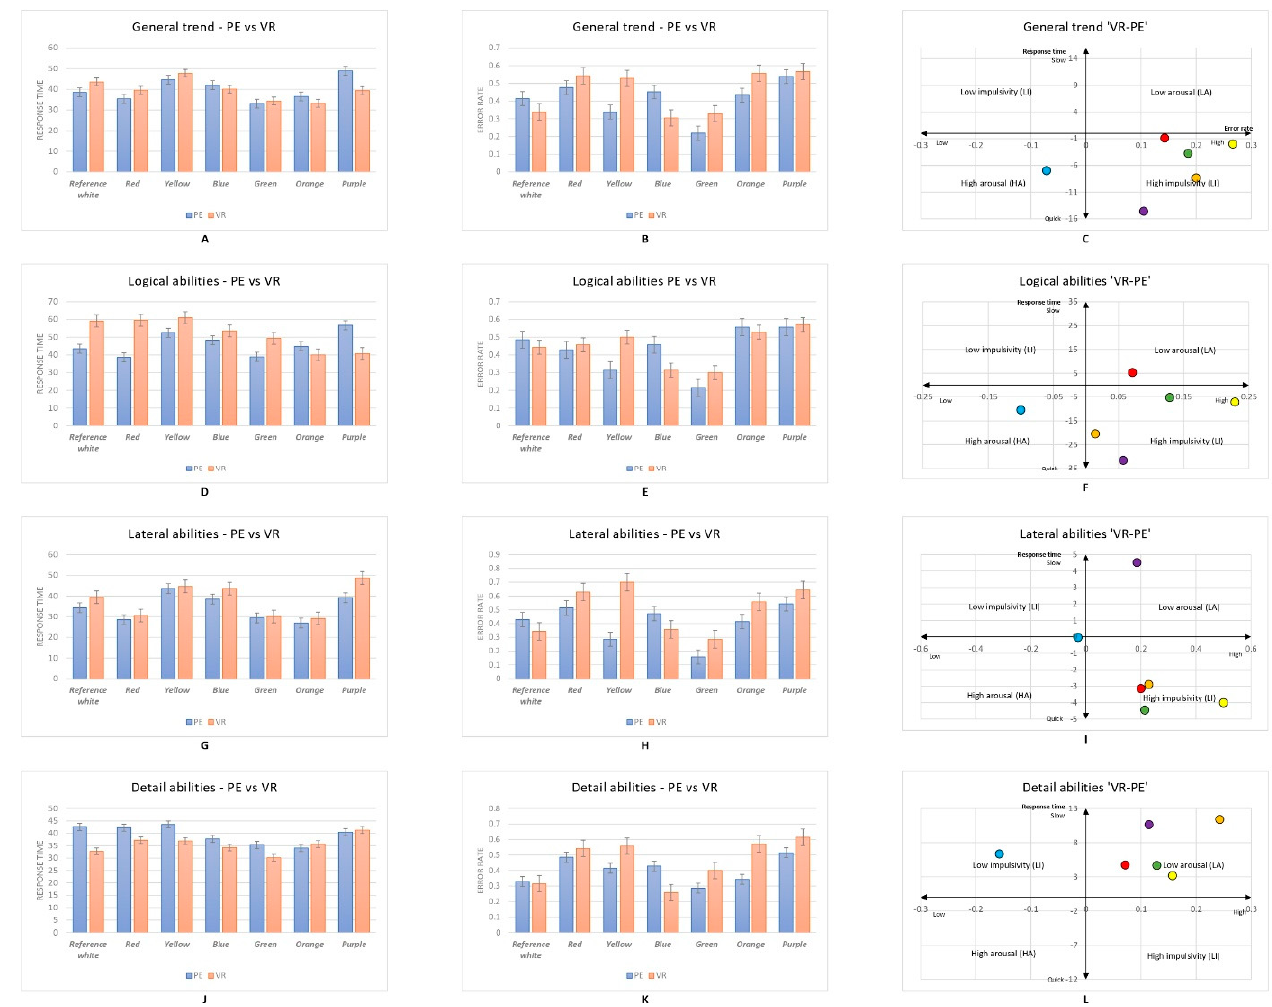
Figure 4. ( A ) General trend of response time by background colour in PE and VR; ( B ) general trend of error rate by background colour in PE and VR; ( C ) colour impacts (in VR compared with PE) on general performance visualised in the Error–Speed space; ( D ) response time of participants’ performance in logical abilities by background colour in PE and VR; ( E ) error rate of participants’ performance in logical abilities by background colour in PE and VR; ( F ) colour impacts (in VR compared with PE) on logical abilities in VR visualised in the Error–Speed space; ( G ) response time of participants’ performance in lateral thinking abilities by background colour in PE and VR; ( H ) error rate of participants’ performance in lateral thinking abilities by background colour in PE and VR; ( I ) colour impacts (in VR compared with PE) on lateral thinking abilities in VR visualised in the Error–Speed space; ( J ) response time of participants’ performance in detail abilities by background colour in PE and VR; ( K ) error rate of participants’ performance in detail abilities by background colour in PE and VR; ( L ) colour impacts (in VR compared with PE) on detail abilities in VR visualised in the Error–Speed space. The bars represent mean changes, while the error bars are the standard error of the mean across individual participants. People’s responses to the reference white background are located on the centre axis in figures ( C , F , I , L ). VR: virtual reality; PE: Physical environment.